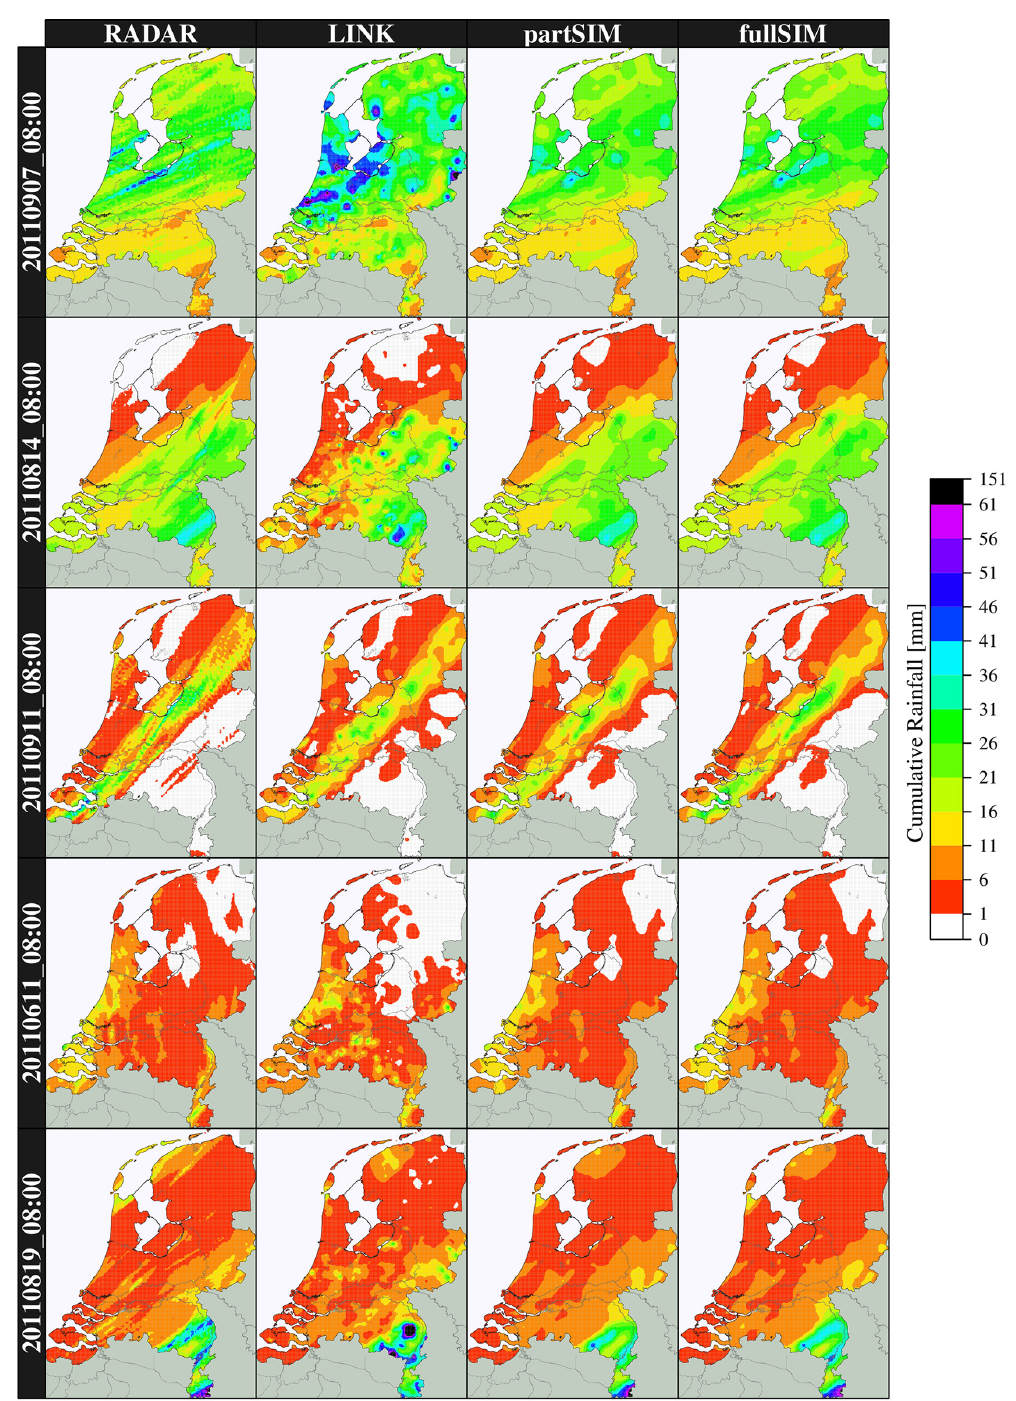
Figure A1. Comparison of daily interpolated rainfall maps with regard to radar rainfall fields (ground truth; left column). The rows show five of the 12 days of the validation period. Daily rainfall maps were aggregated from 15min rainfall maps. The row labels indicate the end UTC for which the maps were